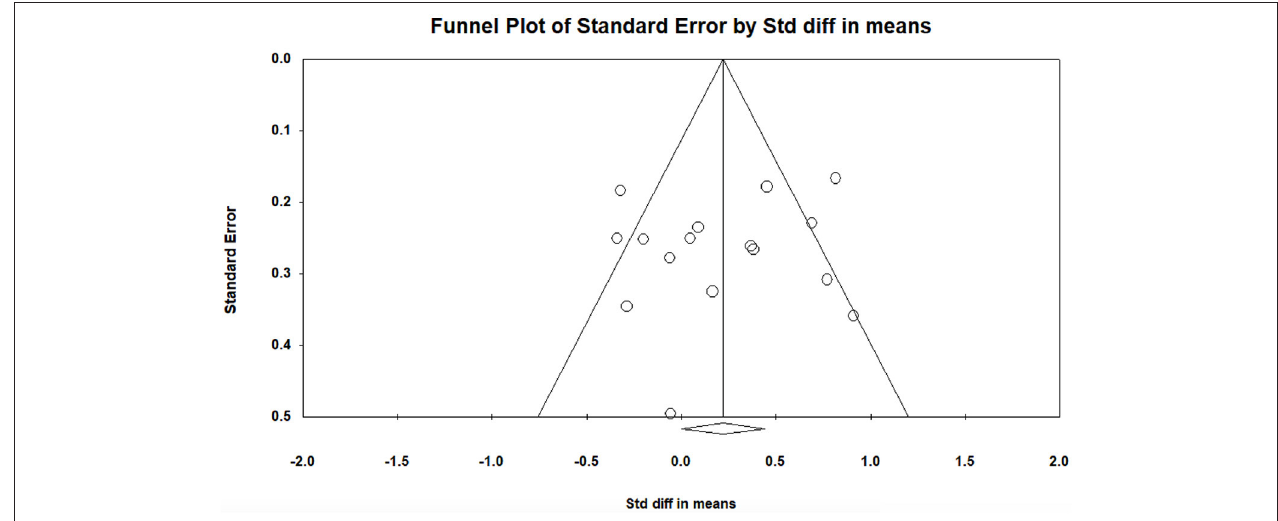
FIGURE 2 | A funnel plot to assess potential publication bias in the main analysis.